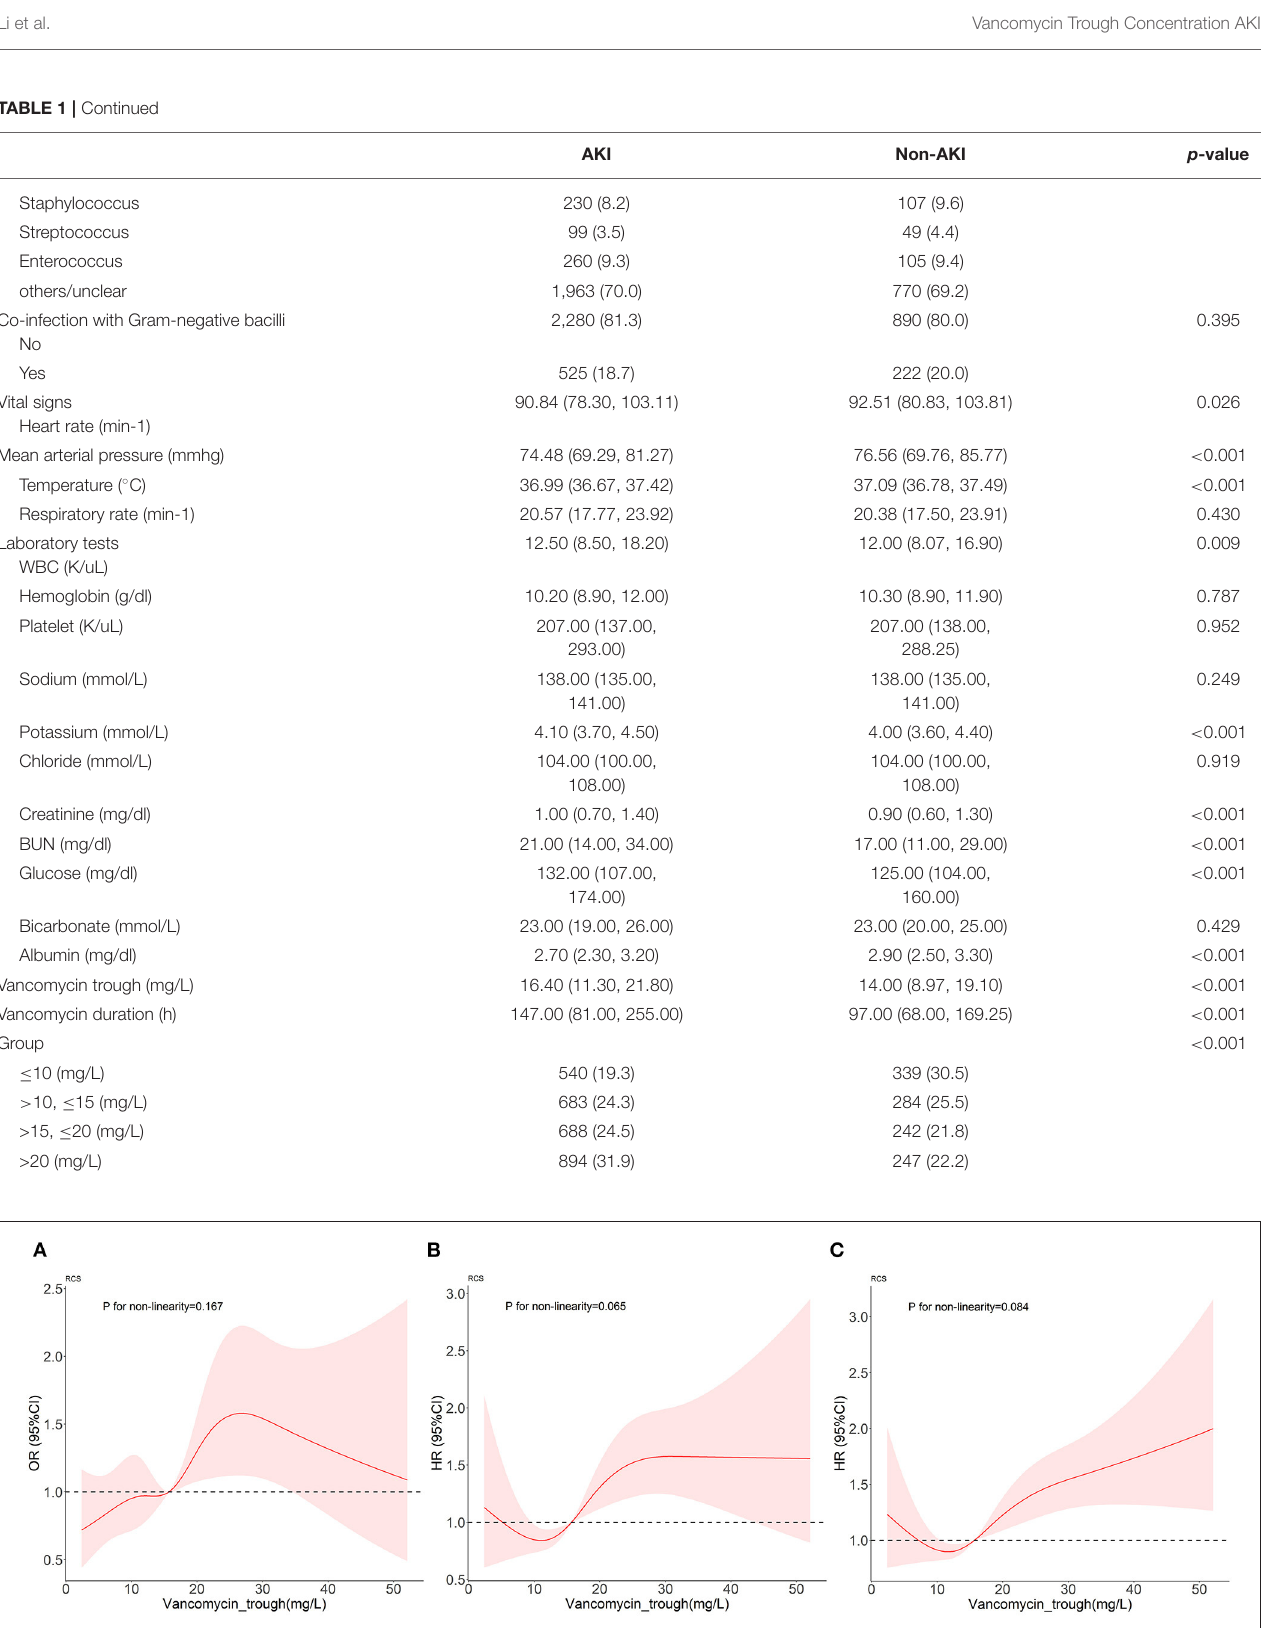
FIGURE 3 | Dose-response relationships between vancomycin trough concentration and the outcomes. (A–C) represent the occurrence of AKI, ICU mortality, and in-hospital mortality.